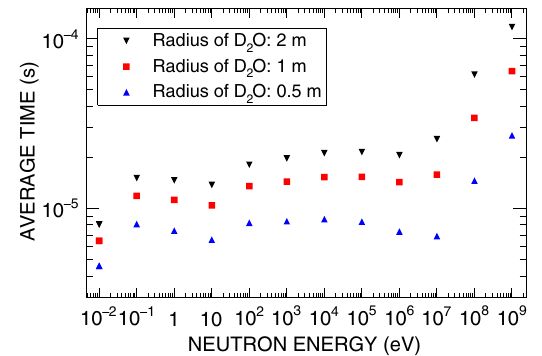
FIG. 3. Total time periods neutrons spend inside the ion beam pipe which is surrounded by a moderator of 1 m radius. The differenthistogramscorrespondtodifferentprimaryneutronenergy ranges, which were chosen exemplary from the entire neutron energy range from 10 − 2 to 10 9 eV. For each energy decade, 10 6 initial neutrons were simulated. Events where the neutron bypasses the ion beam pipe are not shown (zero suppressed). About 30% to 50% of all neutrons pass the ion beam pipe at least once. The x-axis has a logarithmic binning with ten bins per time decade.